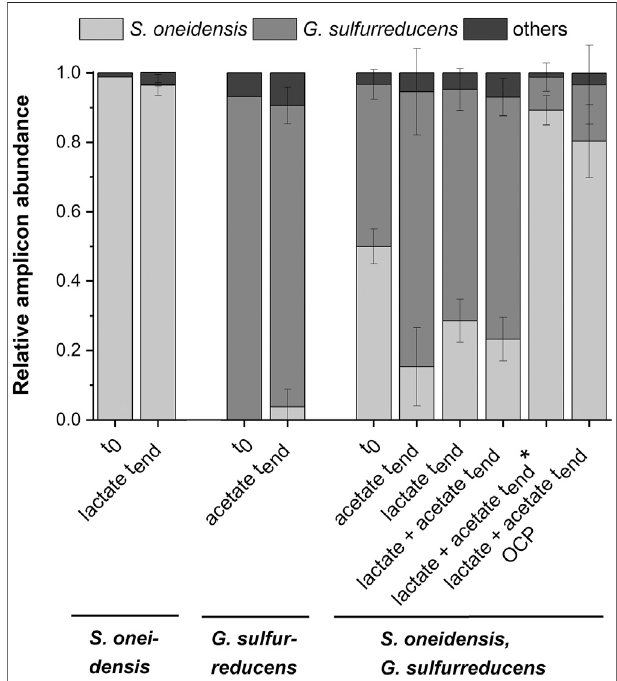
FIGURE 3 | Microbial composition based on 16s rRNA TRFLP analysis (mean±sd)forthepureculturesexperimentswith S.oneidensis ( n =8)and G. sulfurreducens ( n = 7), the co-cultivation experiments with both strains (acetate n =3;lactate n =6;lactate+actete n =6;lactate+actete* n =2) as well as the OCP ( n = 5) control at the start ( t 0 ; S. o. n = 1, G.s. n = 1, co- cultivation n = 3), and the end ( t end ) of the experiment (mean ± sd is not provided for other